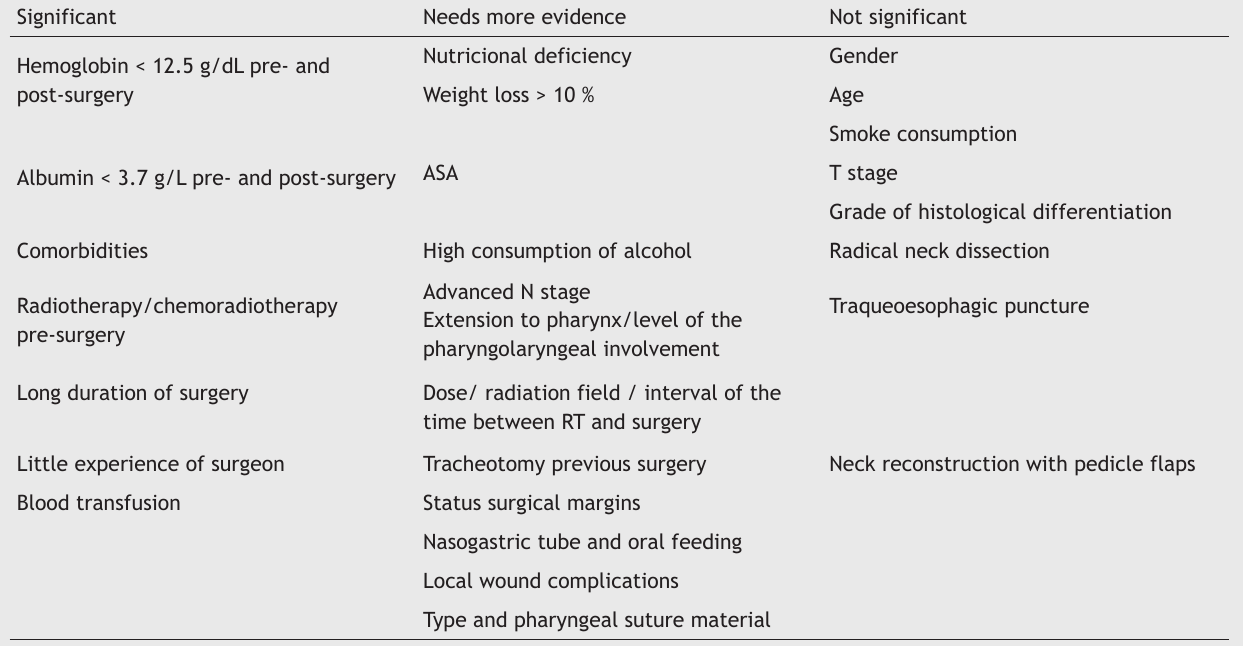
Table 3 Summary of studied risk factors for pharyngocutaneous fistula